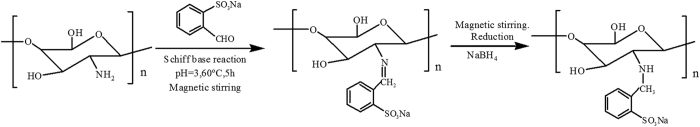
Reaction route for NSBC.